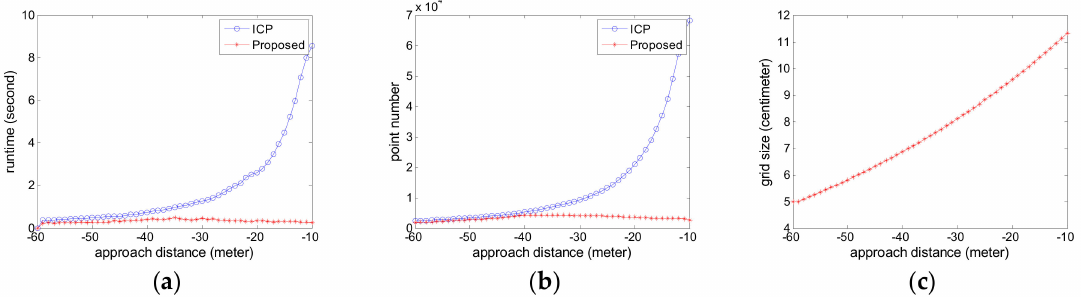
Figure 12. The runtime comparison in Experiment 2 ( a ) the runtime for each sensor data; ( b ) the point number of each sensor data; ( c ) the grid size used in the simplification process for each sensor